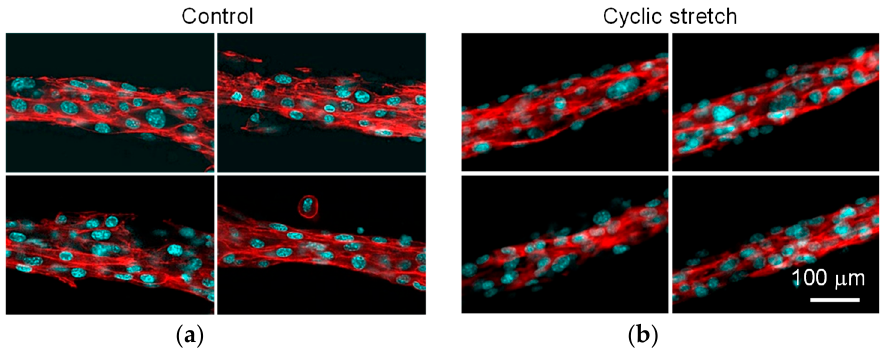
Figure 6. Fluorescent images of rhodamine-phalloidine / DAPI counterstaining to visualize the actin cytoskeleton of C2C12 cells in ( a ) control and ( b ) cyclic stretch groups. Scale bar: 100 µ